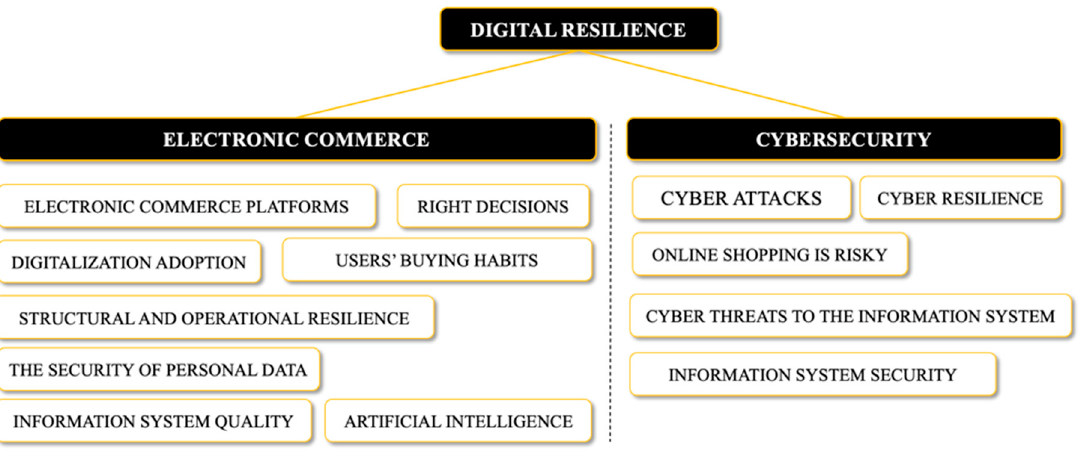
Figure 1. Literature review summary designed by authors.